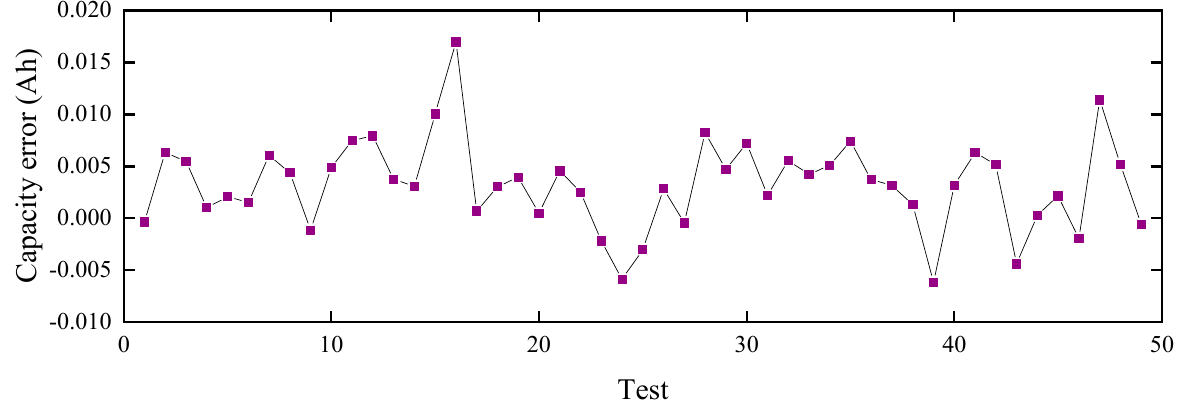
Figure 16. Test error of actual remaining capacity estimation.